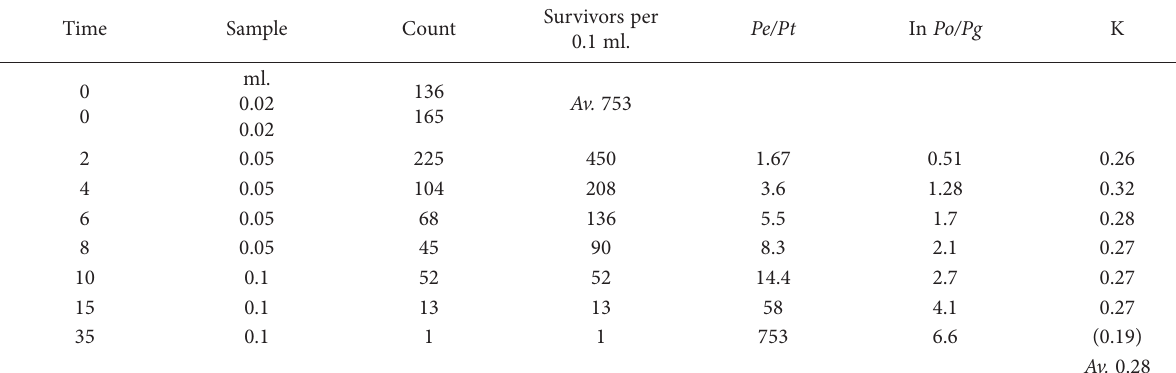
Table I. The Inactivation of TT Bacteriophage by Shaking in Saline-Buffer Diluent at 26°C. and pH 6.5 Time